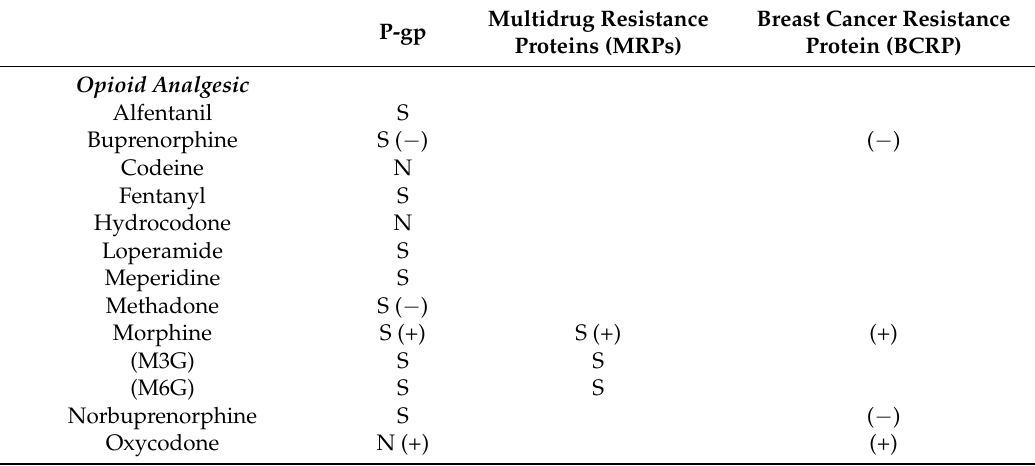
Figure 1. Blood-Brain Barrier Localization of ATP-Binding Cassette (ABC) Transporters relevant to Opioid Transport. Table 1. Known opioid substrates and inducers/inhibitors of ATP-Binding Cassette (ABC) transporters at the blood-brain barrier.